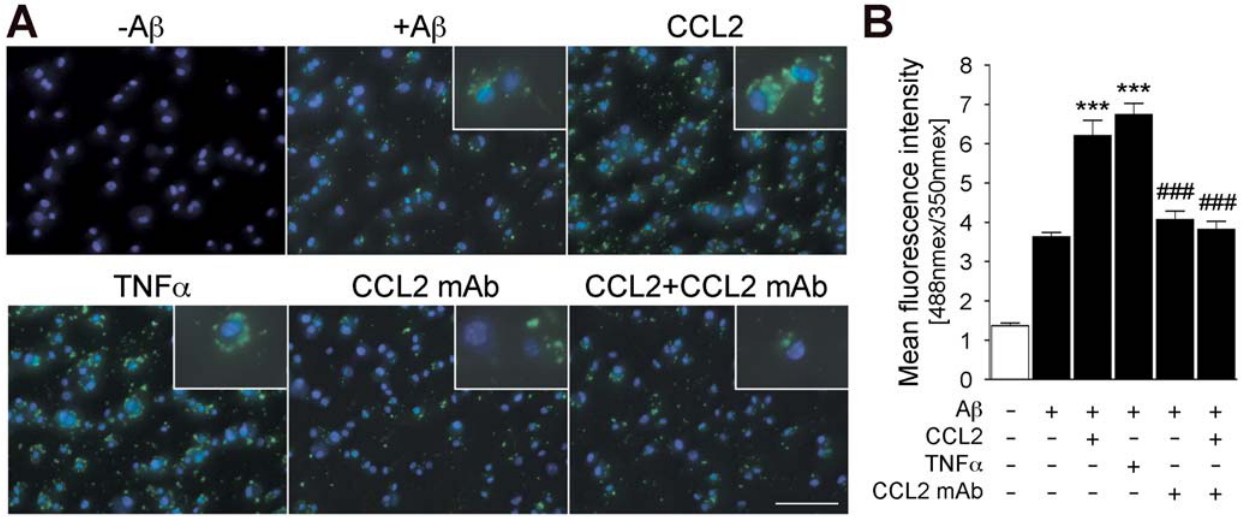
Figure 6. CCL2 and TNF- a enhances A b aggregation in mouse microglia. (A) Primary mouse microglia were incubated without A b (-A b ), with A b (other panels), and co-incubated with 10 ng/ml CCL2, with 10 ng/ml TNF- a , with 1 m g/ml neutralizing anti-CCL2 antibody (CCL2 mAb), or co- incubated with 10 ng/ml CCL2 and 1 m g/ml CCL2 mAb (CCL2 + CCL2 mAb) for 1 h, followed by immunofluorescence with NU-2 anti-A b oligomer antibody (green) and Hoechst33342 for nuclear staining (blue). Merged captured images were shown. Insets are high-magnification. Scale bar, 100 m m. (B) Flurolometric quantification of A b oligomer fluorescent signal (Ex/Em=488 nm/519 nm) normalized by the nuclear staining signal (Ex/ Em=350 nm/461 nm, n=3 per group). White or black bars represent incubation of microglia with no A b (white, negative control) or with 10 m M A b 42 (black) A b , respectively. *** and ### denote p , 0.001 versus A b group, and versus CCL2 group, respectively.